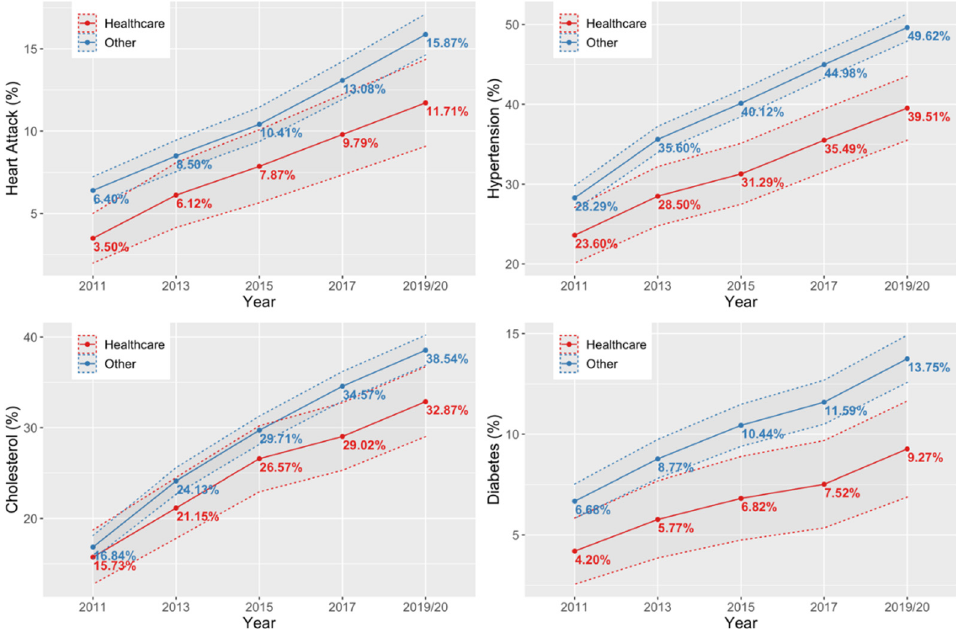
Figure 3. Longitudinal comparison of health condition prevalence between healthcare workers and other industries.